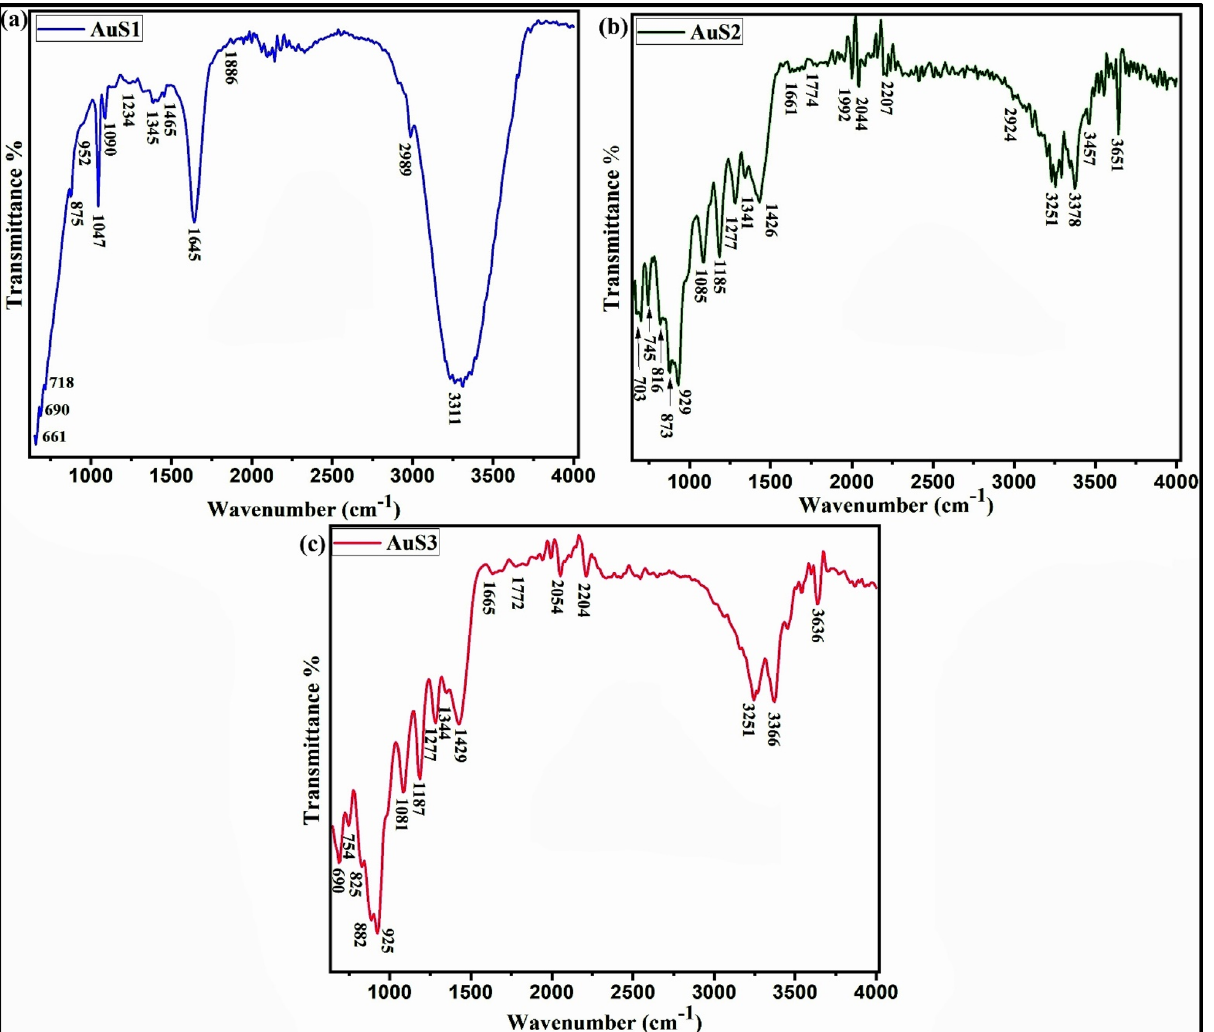
Figure 5. FTIR spectra for AuNPs using essential oil of C . flexuosus from different altitudes of Palampur (AuS1) ( a ), Haryana (AuS2) ( b ), and Dehradun (AuS3) ( c